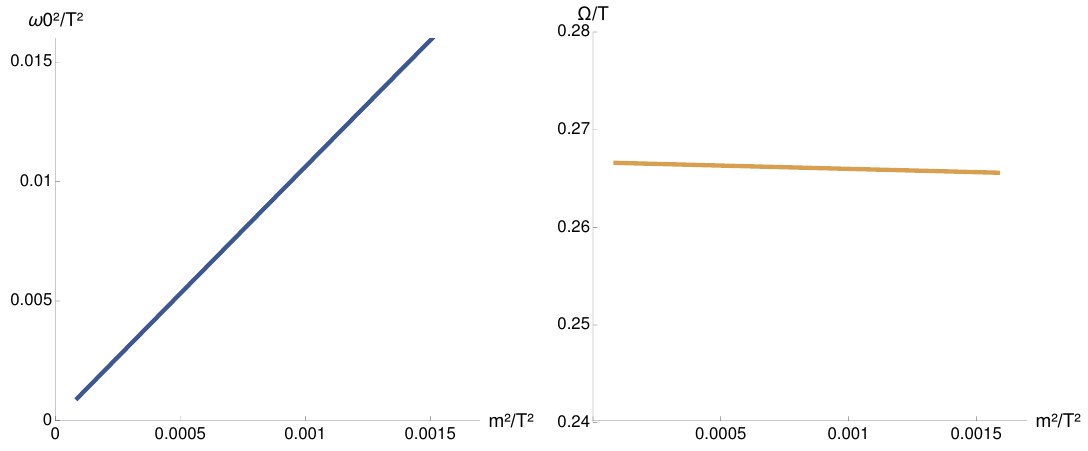
Figure 14 . Left: (cid:12)tted (cid:10) =T for (cid:12)xed m=T = 0 : 01. Right: (cid:12)tted ! 2 In both cases the deviation from the expected behaviour appears at small (cid:12) , i.e. away from the pseudo-spontaneous limit.